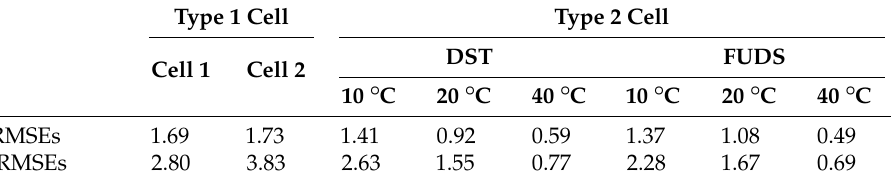
Table 6. RMSEs (%) of SOC estimation results for different datasets.